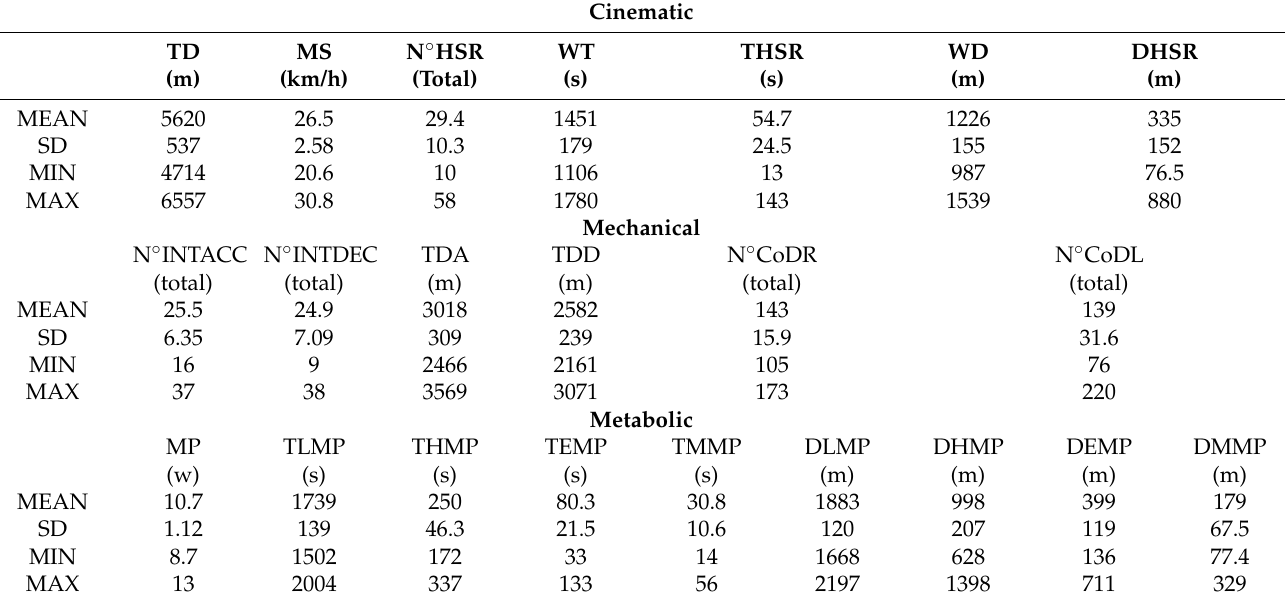
Table 2. Descriptive statistics of the external load indicators.